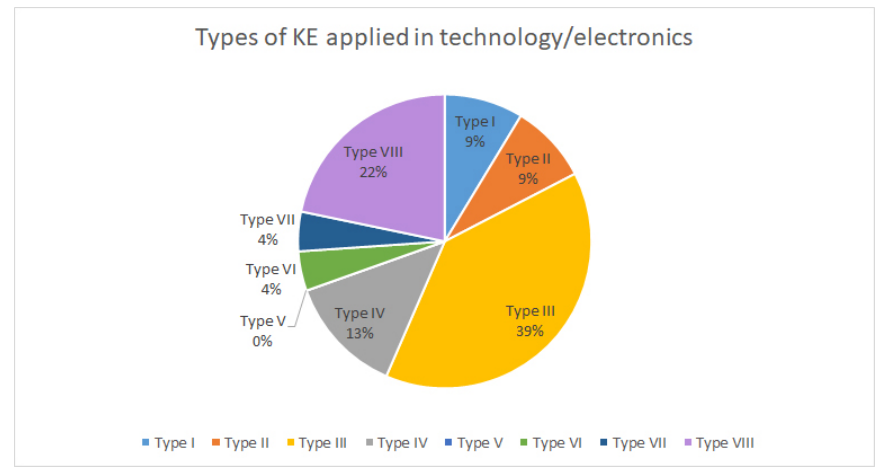
Figure 10. Classification by category of technological and electronic products.